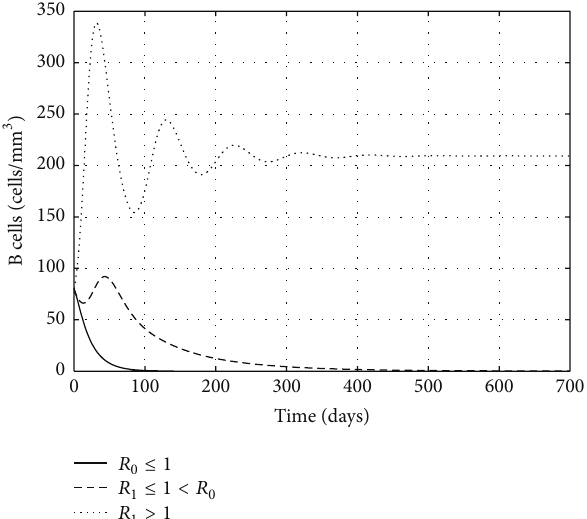
Figure 7: The concentration of short-lived infected cells for model (104).